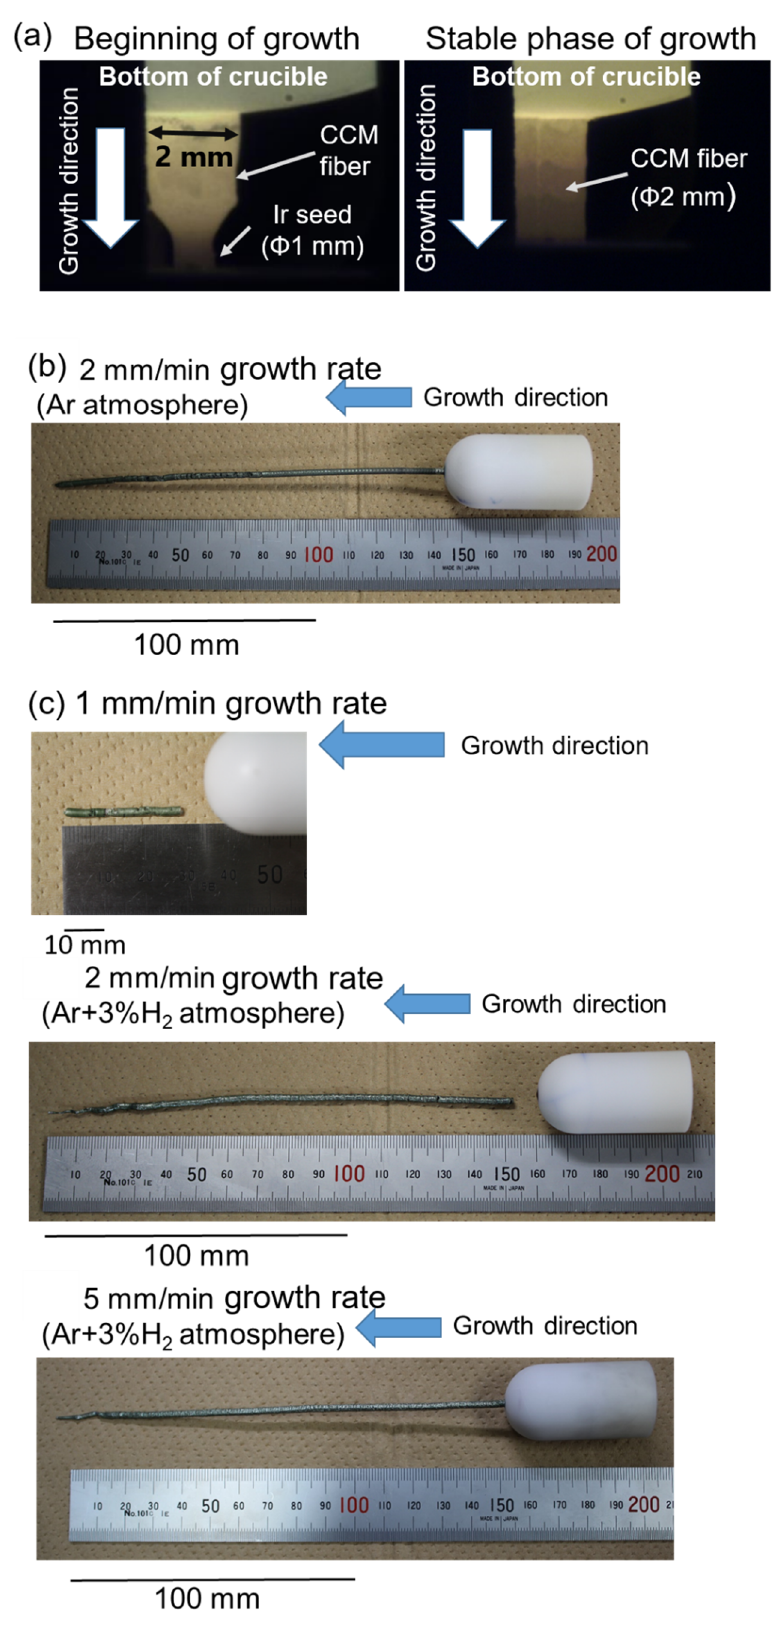
Figure 1. ( a ) Liquid–solid interface during fabrication of Co-Cr-Mo fiber. Co-Cr-Mo fibers fabricated under ( b ) Ar and ( c ) Ar + 3%H 2 atmosphere.